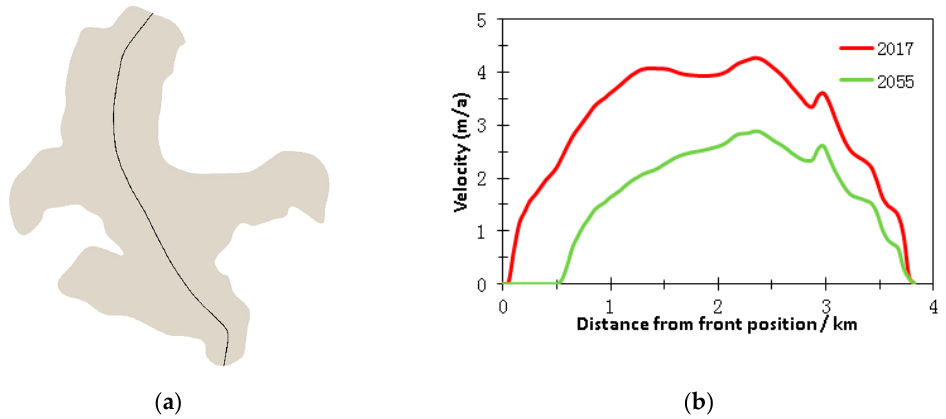
Figure 11. ( a ) The sketch of central flow line of AL. ( b ) Curves of simulated velocity (m/a) along central flow line in 2017 and 2055.